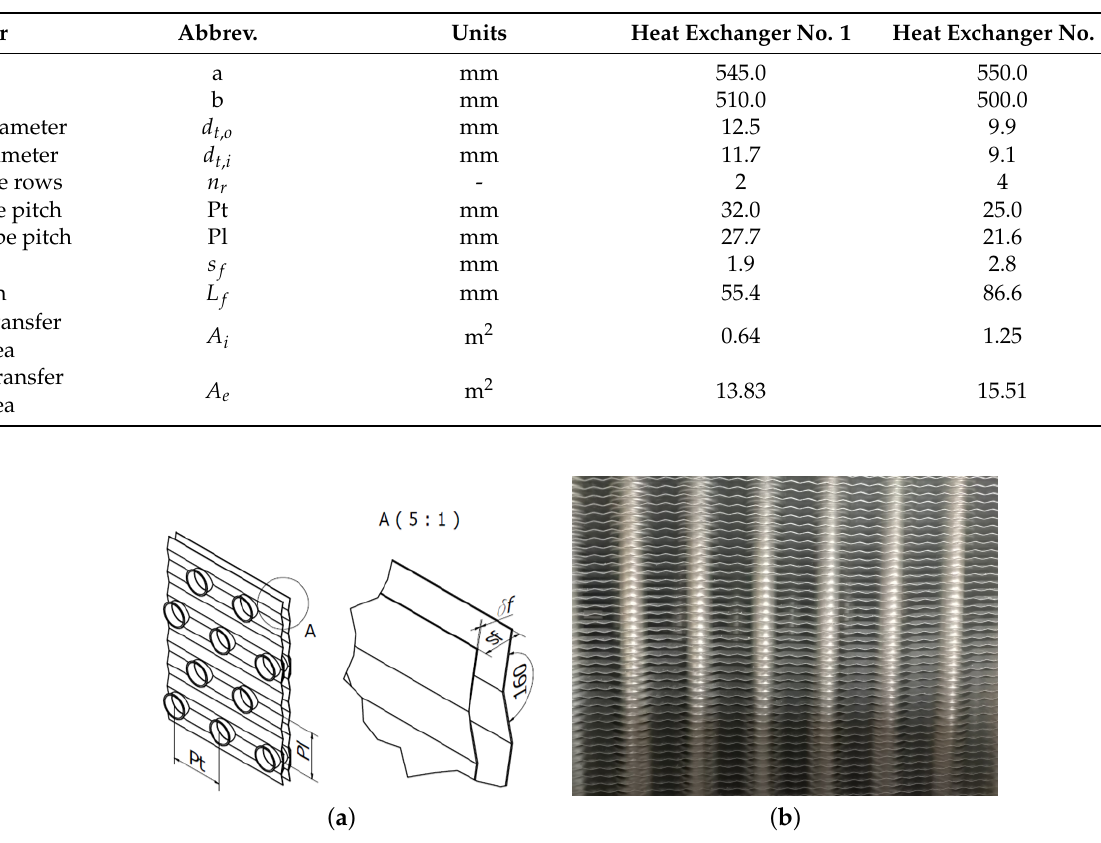
Figure 2. Detailed geometry of the test wavy fins with selected markings. ( a ) Geometric model with markings. ( b ) Picture of the fins in heat exchanger number 2.